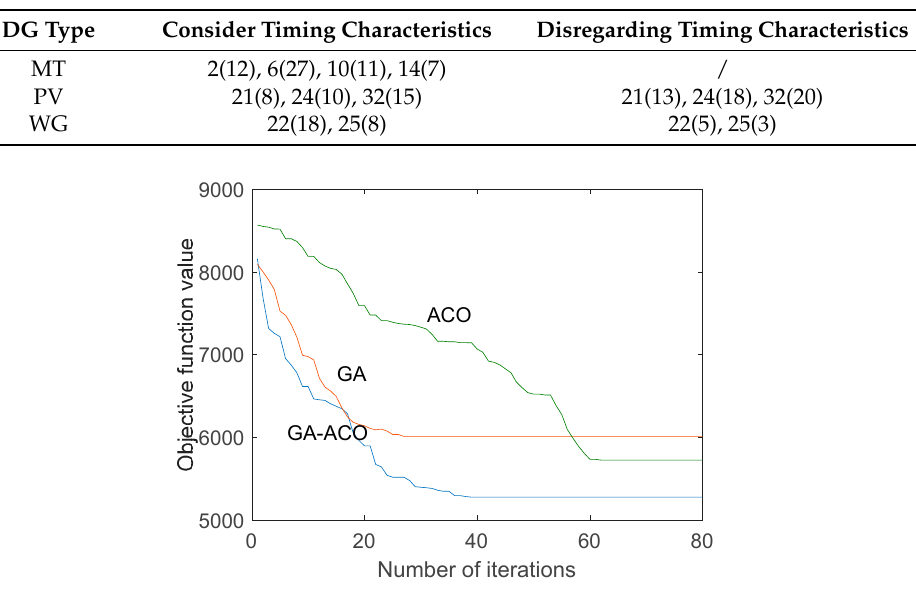
Table 6. Planning schemes considering load growth.